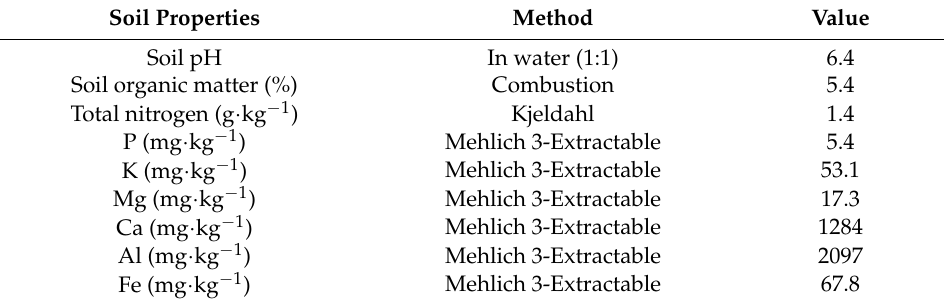
Table 1. Initial chemical properties of the mineral soil (Mistassini loamy sand) used for this